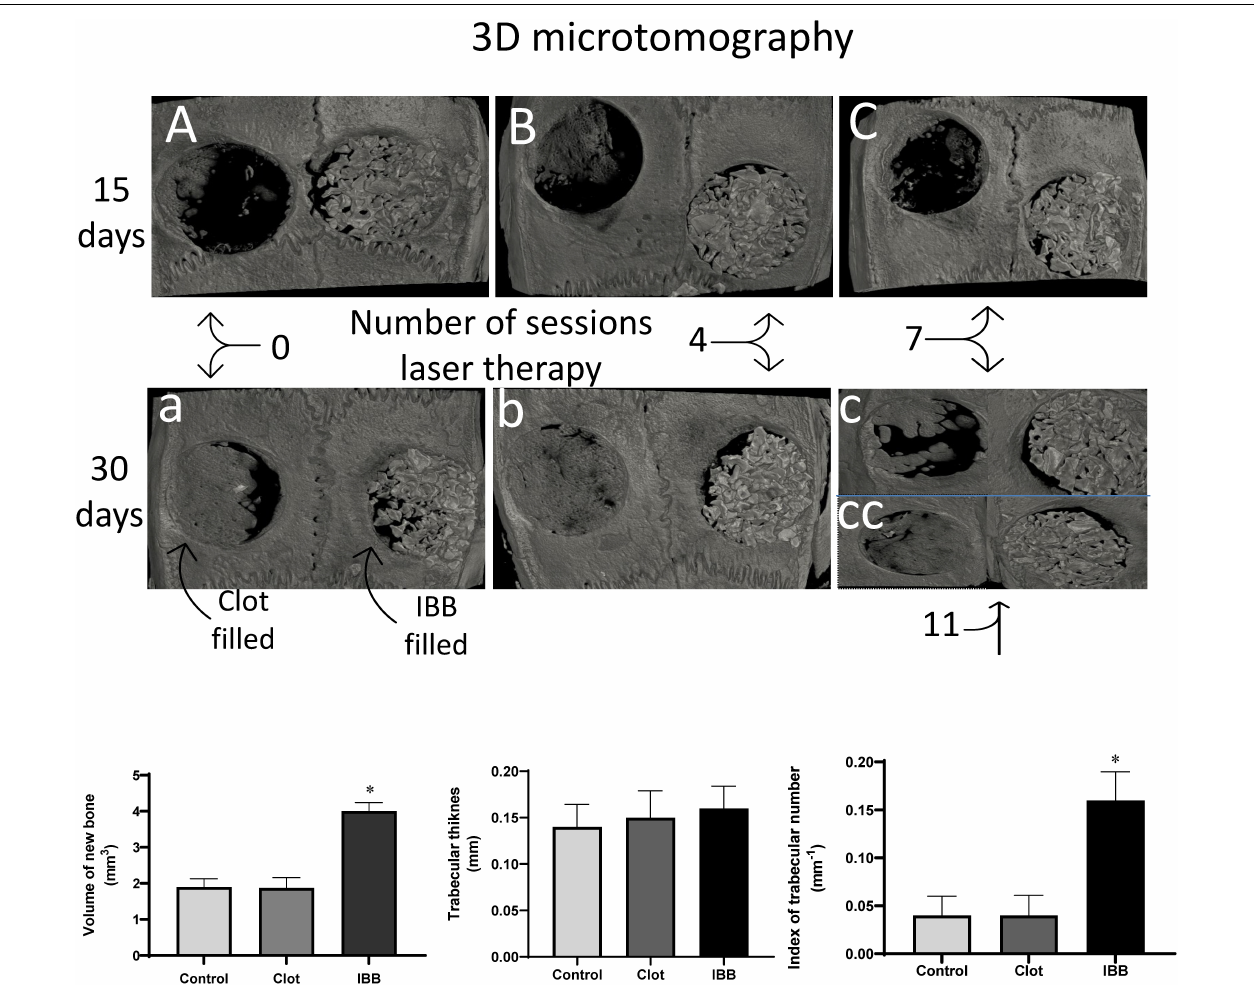
FIGURE 7 | Typical 3D microtomographic images, comparing blood clot-filled (left) with IBB-filed (right) cavities and comparing the analysis at 15 days (A, B, and C) with 30 days (a, b, c, and cc). Figure illustrates the effects of the number of sessions of LT, which in the group of 30 days was extended to a group of 11 sessions (cc). At the bottom are shown the qualitative data obtained by the microtomographic analysis. Values are mean ± Standard error of the mean. ∗ p < 0.05 vs, Control and clot-filled groups. Statistical analysis: two-way ANOVA for N = 6 rats per